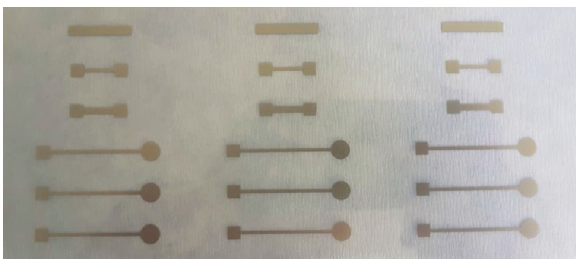
Fig. 2 – Inkjet-printed silver features on flexible PET films. From top to bottom: lines for SEM imaging and thickness cal- culation, lines for resistance measurement, planar electrodes for potential electrochemical measurements (not included in this study).